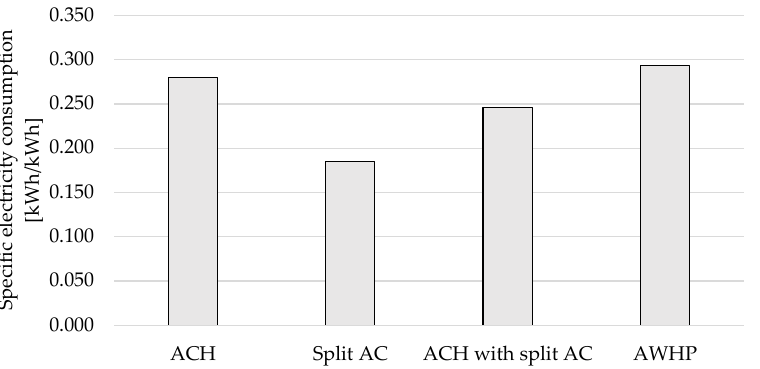
Figure 12. Specific electricity consumption per kWh of produced cooling energy with ACH, split AC, and ACH with split AC and AWHP. CO 2 emissions are calculated from the final energy using CO 2 emission factors. The annual emissions for the systems are shown in Figure 13. Emissions are the lowest for the systems that operate with AWHP and PV modules (AWHP-2). As expected, emissions are the highest for systems with solar panels and fuel oil boilers, followed by systems with solar panels and natural gas boilers.